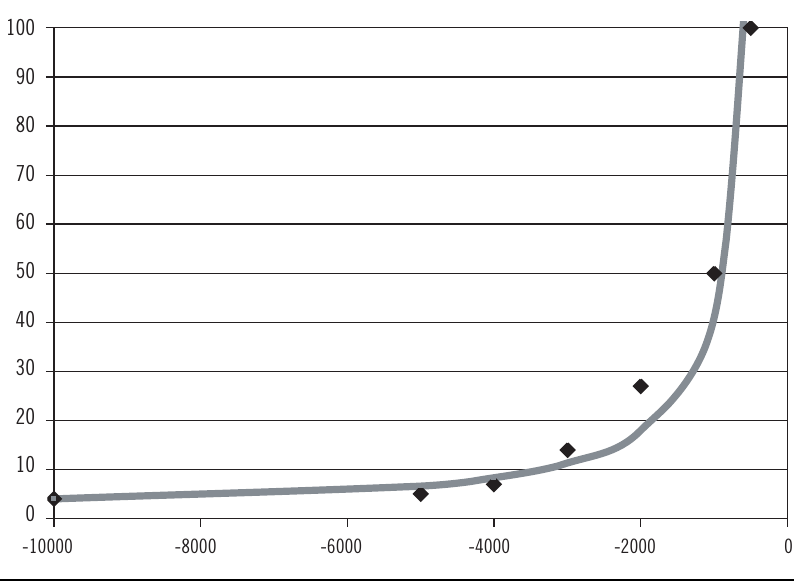
Note: The solid grey curve has been generated by the model; black markers correspond to the estimates of world population by McEvedy and Jones (1978) and Kremer